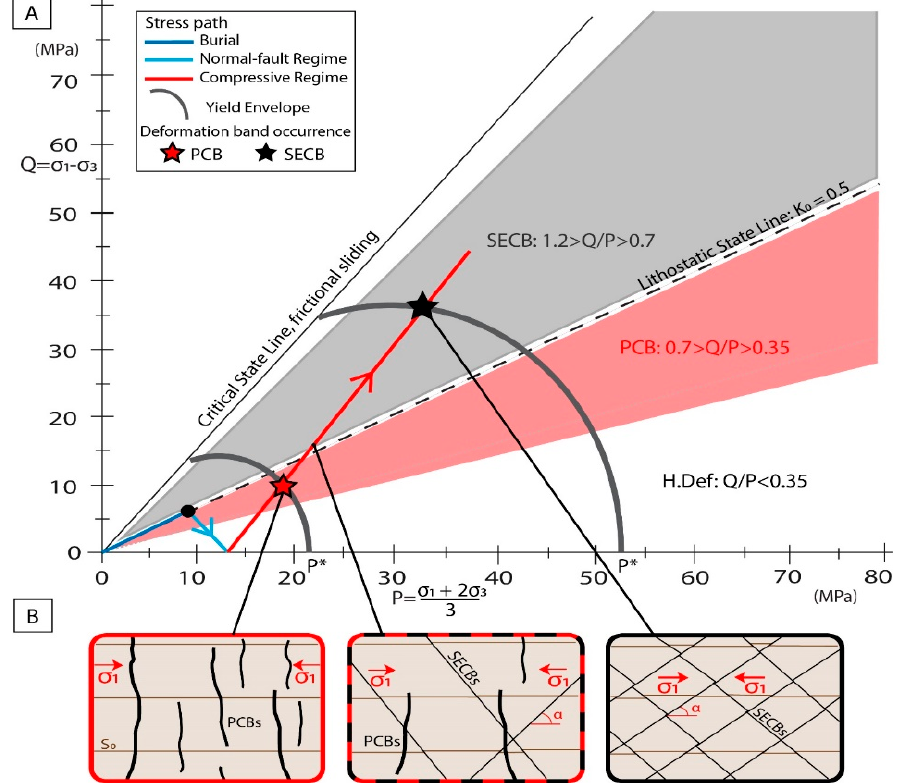
Figure 1. (A ) Q-P plot with definition of the stress path (adapted from Figure 17 in [24]; Burial in dark blue and extensive regime in light blue, followed by the compressive regime in red). The stress path crosscut the envelopes, leading to the deformation bands’ set up. The type of band depends on the crosscut area; Shear Enhanced Compaction Bands (SECBs) will form in Q/P ratios between 0.7 and 1.2 (grey area); Pure Compaction Bands (PCBs) are set up between 0.7 > Q/P > 0.35 (red area); finally, for lower values of Q/P ratios (below 0.35), no localized structures will form as the deformation is homogeneous. ( B ) Examples of band structures potentially set up depending on the Q/P ratios, where α represents the angle between the maximum principal stress and the band orientation.